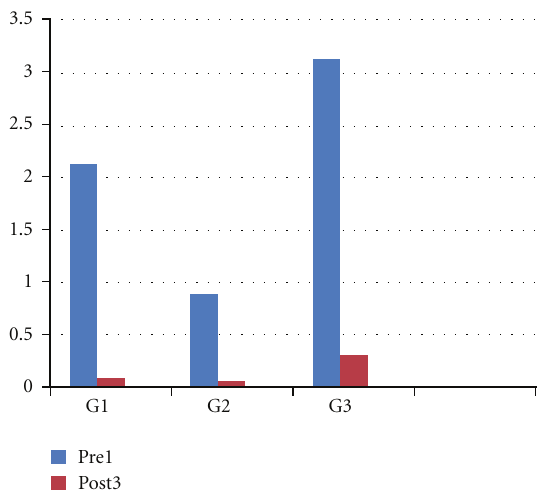
Figure 6: Illustrative representation of the improvements to the tactile stimuli from the first treatment to the third one.